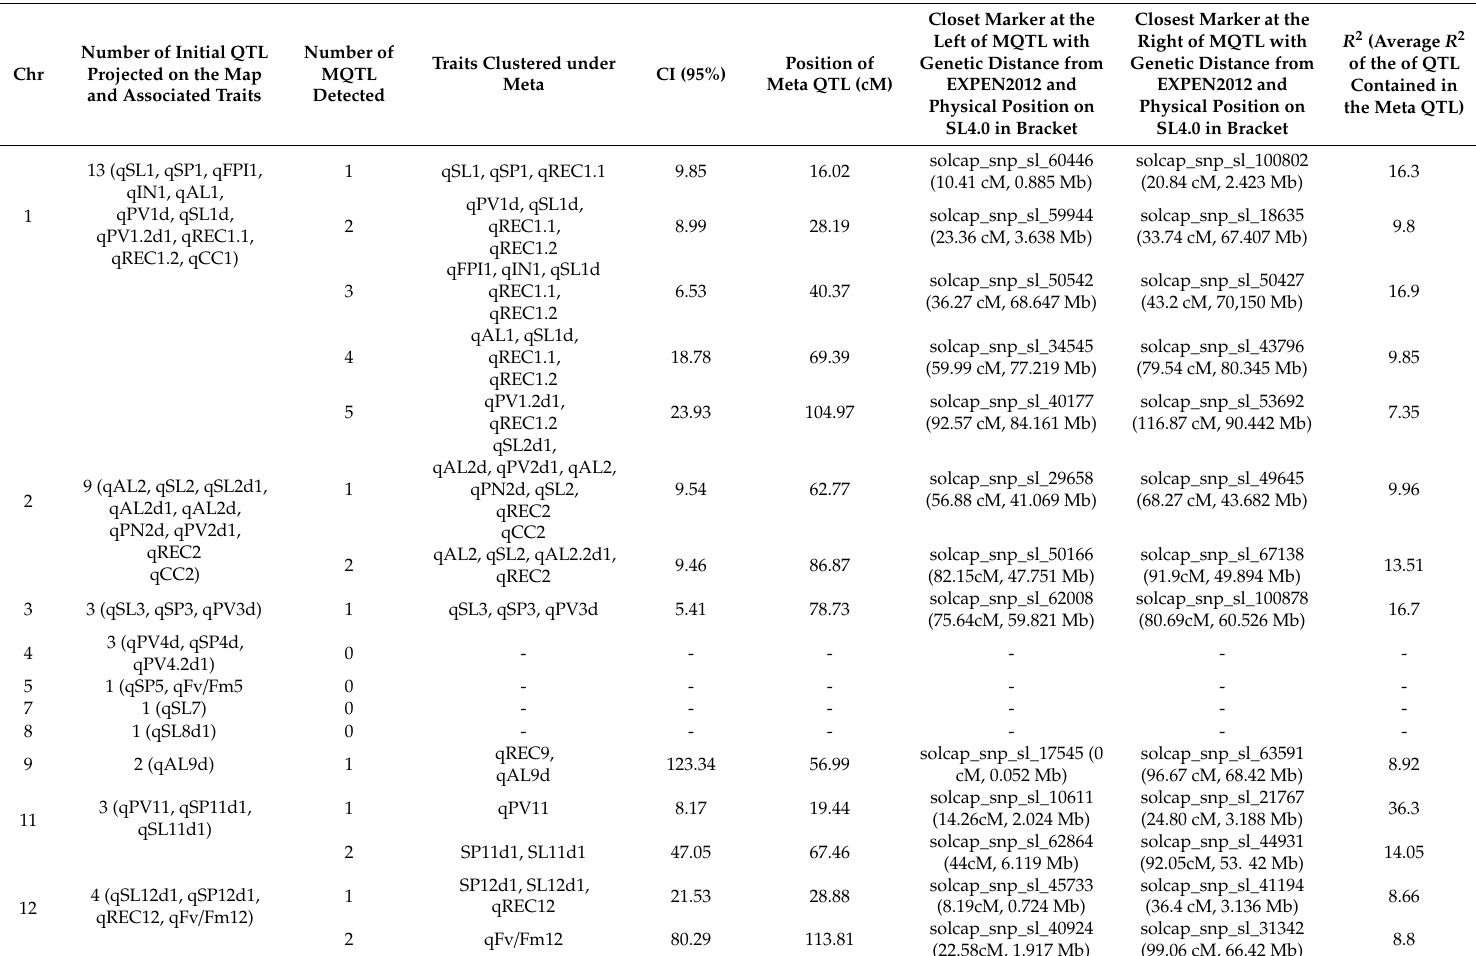
R 2 (Average R 2 of the of QTL Contained in the Meta